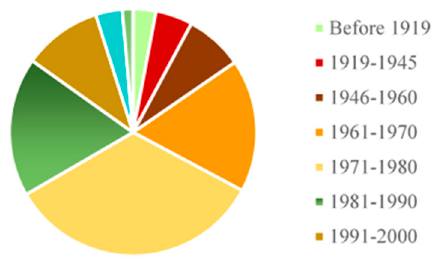
Figure 11. Construction period of Siatista’s buildings (National Statistical Authority).